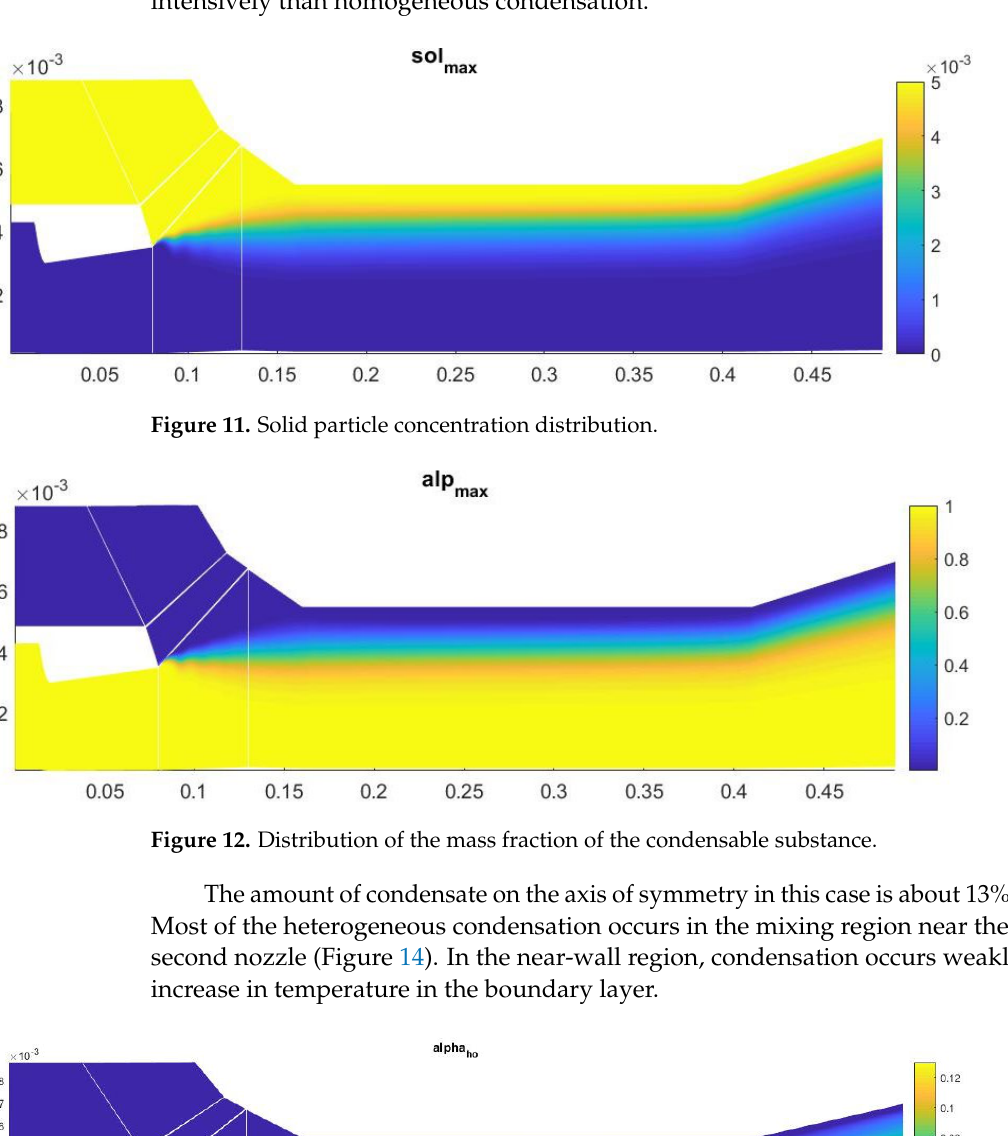
Figure 14. Contours of the field of the mass fraction of water formed in heterogeneous condensation.